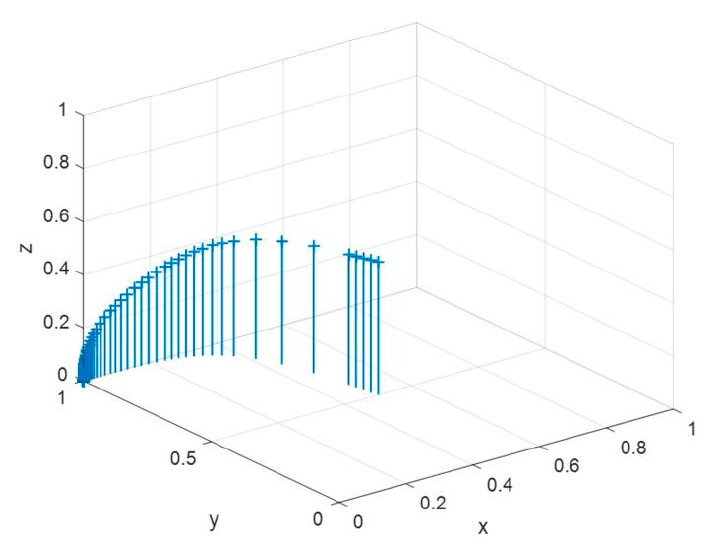
Figure 6. Three-dimensional diagram of evolutionary path at stable point (0, 1, 0).